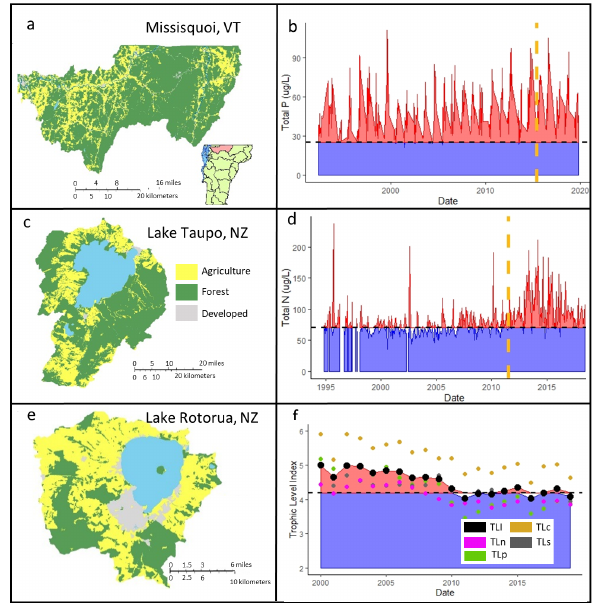
Fig. 1 . Land use maps and water quality trends in Missisquoi watershed, Vermont, Lake Taupo, and Lake Rotorua watersheds. Figures (a), (c), and (e) shows land use split between agriculture, forest, and developed land in (a) Missisquoi watershed, Vermont (Multi-Resolution Land Characteristics Consortium 2016), (c) Lake Taupo watershed, New Zealand, and (e) Lake Rotorua watershed, New Zealand (Landcare Research New Zealand Ltd 2015). Note that the Vermont policy is implemented at the state level across all watersheds (see subset of Vermont state in Figure a), but for the purpose of land use, we show one Vermont watershed, the Missisquoi, here at a similar scale to the Taupo and Rotorua watersheds. Figures b, d, and f show corresponding long-term water quality trends, by the regionally relevant management metric, in (b) Missisquoi watershed, Vermont (Vermont Department of Environmental Conservation 2020), (d) Lake Taupo watershed, New Zealand (Verburg and Albert 2019), and (f) Lake Rotorua watershed, New Zealand (BOPRC 2020). The black dashed lines represent upper water quality thresholds for desired water quality, with the red portion of the plot representing the water quality above the threshold (BOPRC 2018, LCBP 2018, WRC 2011). Note that plot (b) is total phosphorus, the nutrient of concern in Vermont, plot (d) is total nitrogen, the nutrient of concern in Lake Taupo, and plot (f) is the Trophic Level Index (TLI) in the large black points for Lake Rotorua. Lake Rotorua manages to the TLI, a composite measure of total nitrogen (TLn), total phosphorus (TLp), secchi depth (TLs), and chlorophyll a (TLc), with each of these converted to the same scale via the trophic level equation. The gold lines represent the date at which policy in each region became operational, as the Rotorua policy is not yet operational, there is no gold line in plot